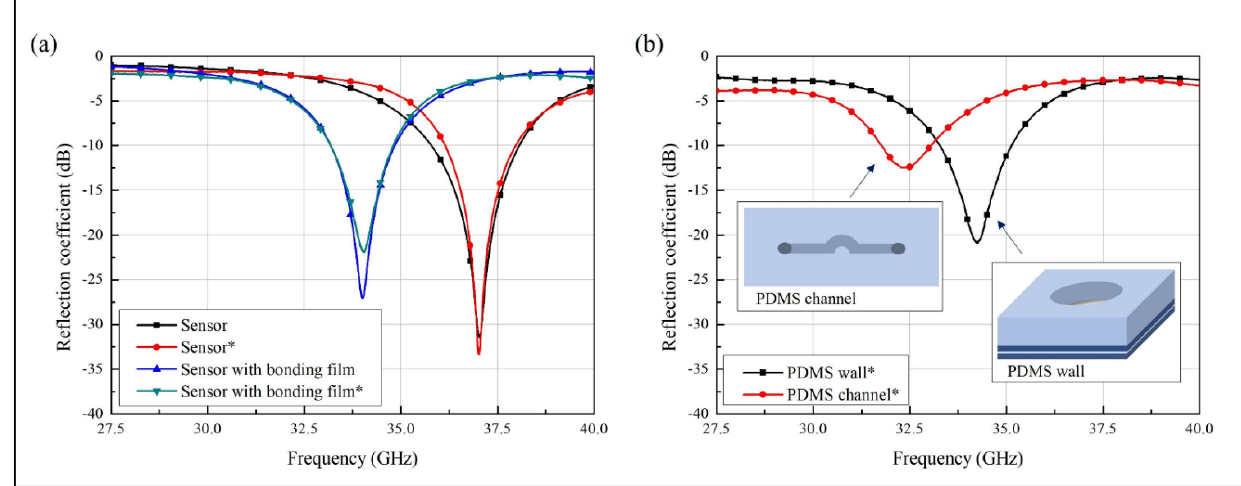
Figure 4. Simulated and measured results of ( a ) the sensor without or with the bonding films. ( b ) Measured results when the PDMS microfluidic channels were used (* is the measured result).